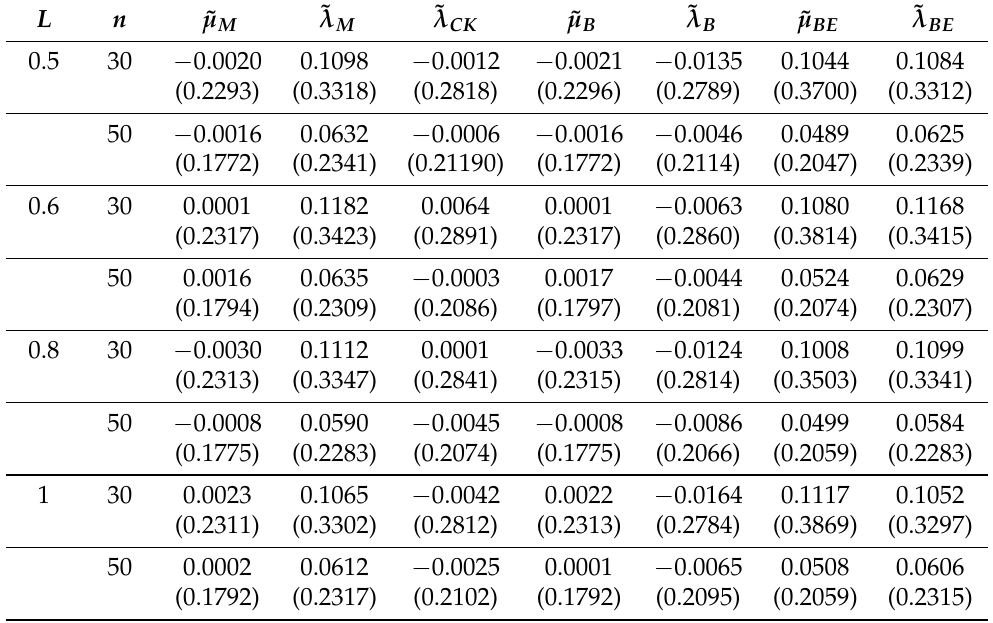
Table 2. The rBias and rRMSEs (in parentheses) of different estimators when µ = 8 and λ =